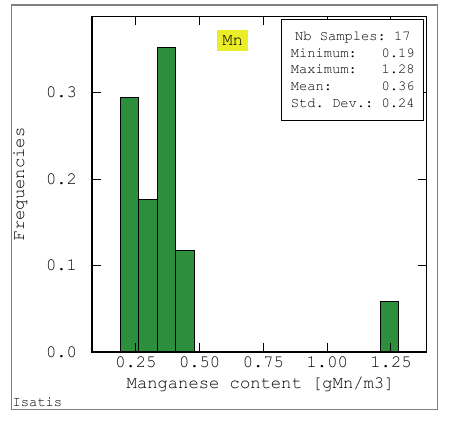
Fig. 7. Histogram of distribution of nitrate of Kłodzko (SW part of Poland); data coming from 14 wells